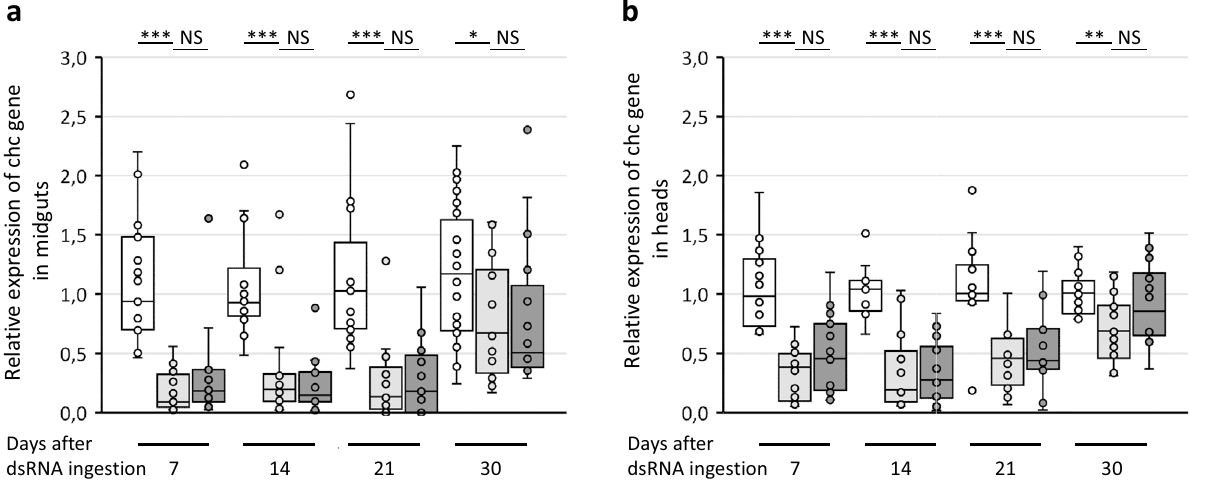
Figure 6. Expression of the clathrin heavy chain (chc) gene in the midguts ( a ) and in the heads ( b ) regards to the reference genes glutathione S-transferase and tubulin β. White boxes correspond to E. variegatus that ingested GFP dsRNA and acquired phytoplasmas on infected broad beans for seven days. Light grey boxes correspond to E. variegatus that ingested chc dsRNA and acquired phytoplasmas on infected broad beans for seven days and then placed onto non-infected broad beans. Dark grey boxes correspond to E. variegatus that ingested chc dsRNA and were then placed onto non-infected broad beans. *Indicates a significant difference with p < 0.05, **with p < 0.01, ***with p < 0.001 and NS indicates no significant difference under the Kruskal– Wallis rank sum test of the R commander package of R software version